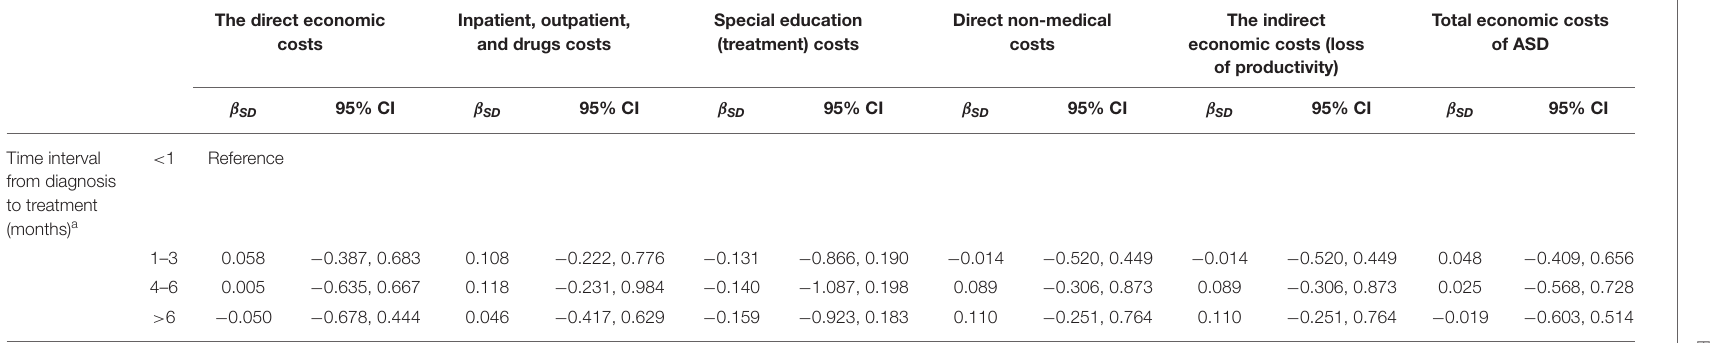
TABLE 5 | Multiple linear regression models for economic costs in the recent 12-month period and time interval from diagnosis to treatment